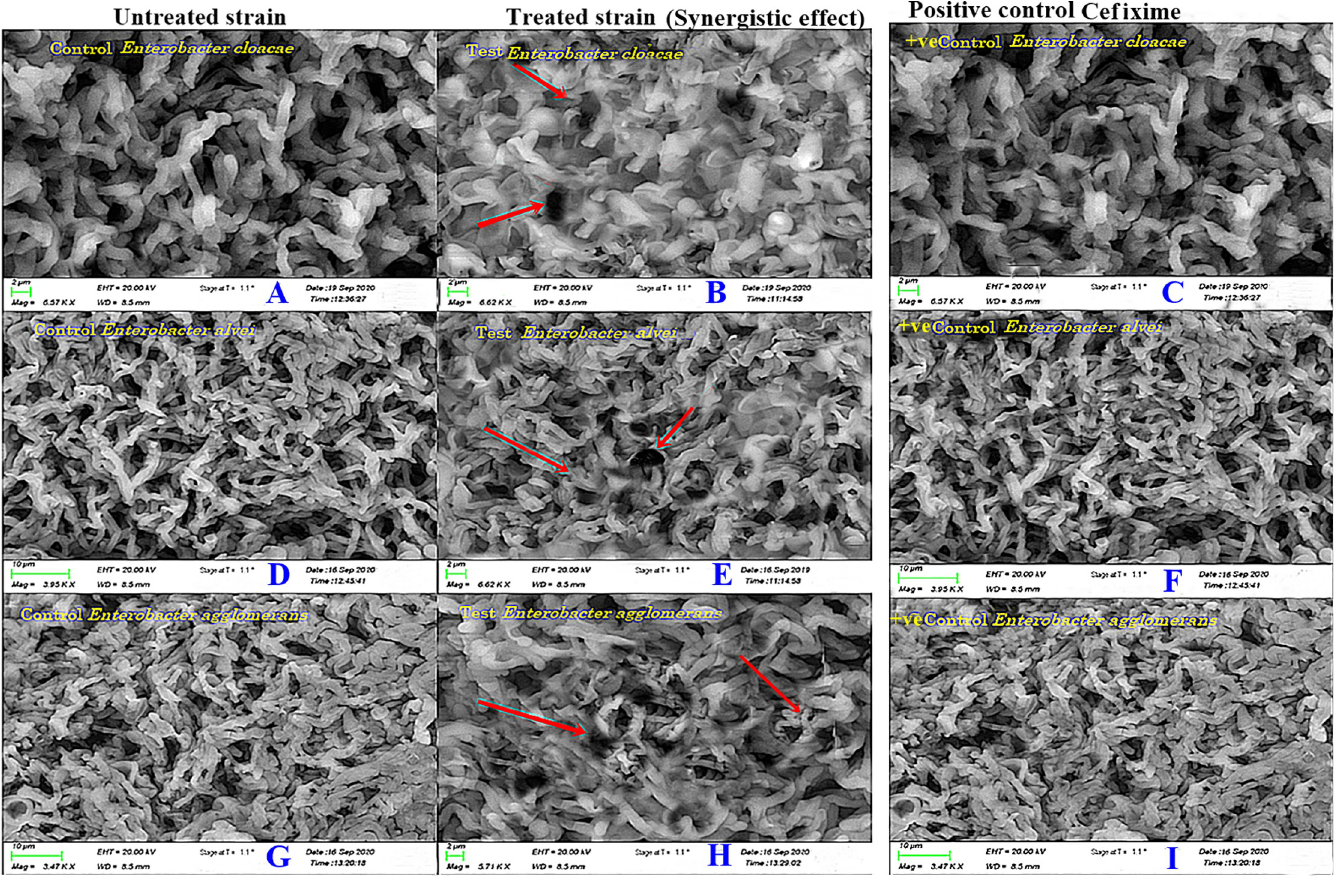
Fig 8. Scanning electron microscopy (SEM) analysis (A) Effects of control on E . Cloacae (B) Effects of lead compound 11 in combination with antibiotic, cefixime against Enterobacter cloacae . (C) Effects of control on E . alvei , (D) Effects of lead compound 11 in combination with antibiotic, cefixime against E . alvei . (E) Effects of control on E . agglomerans (F) Effects of lead compound 11 in combination with antibiotic, cefixime against E . agglomerans . The red arrows indicate the morphological changes exhibited on bacterial cell wall after the use of combination therapy.